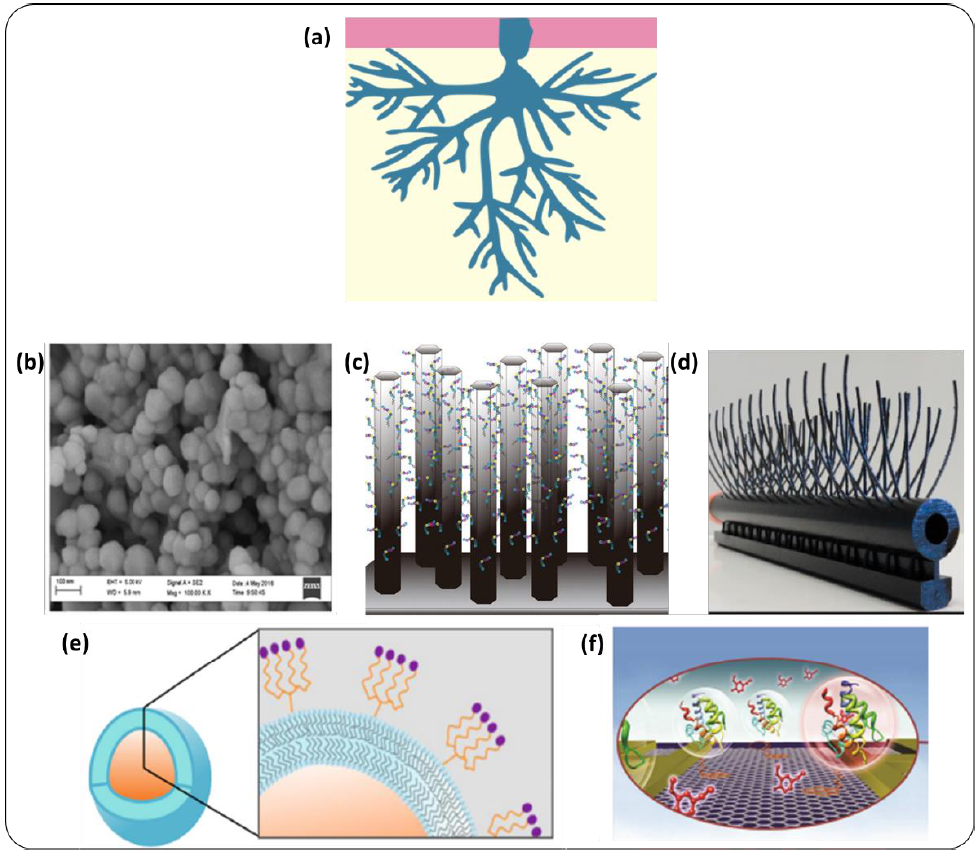
Figure 7. ( a ) Olfactory neurons deploy a large specific surface area in the mucus through their cilia. To mimic this strategy, ( b ) Mascini et al. [103] modified ZnO nanoparticles with peptides, ( c ) Tanaka